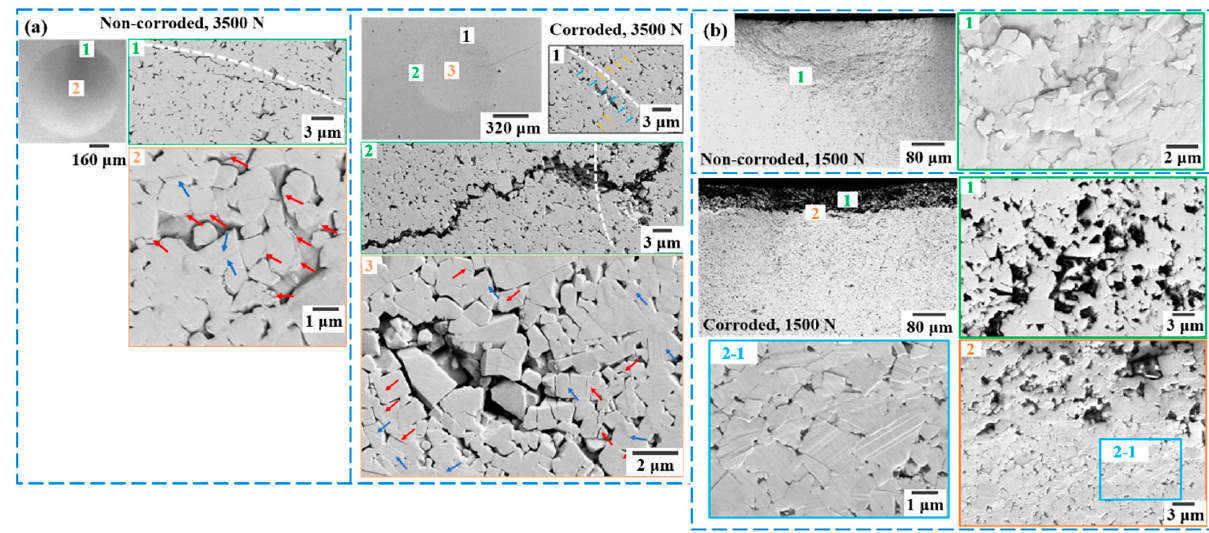
Figure 6. FESEM images of the indented area (residual imprints) for ( a ) 6NiCrM specimen, and ( b ) 6NiCrM “clamped-interface” specimens: micrographs of subsurface damage for non-corroded and corroded (7 days) conditions (adapted from Ref. [45]).